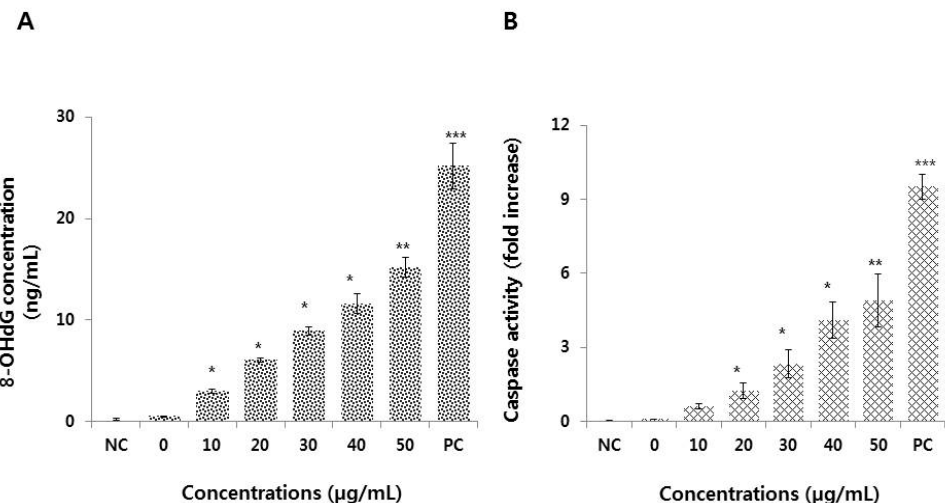
Figure 7. Graphene oxide induces DNA damage and caspase 3 activity in HEK293 cells. ( A ) Cells were treated with various concentration of graphene oxide for 24 h. DNA damage was estimated by ELISA based on the levels of 8-oxo-dG. ( B ) Caspase 3 activity was measured based on the concentration of p-nitroanilide released from the substrate, which was calculated from the absorbance at 405 nm. Results are expressed as the means ± standard deviation of three independent experiments. The treated groups showed statistically significant di ff erences from the control group. * p < 0.05 was considered significant; ** p < 0.01 was considered highly significant and *** p < 0.001 was considered very highly